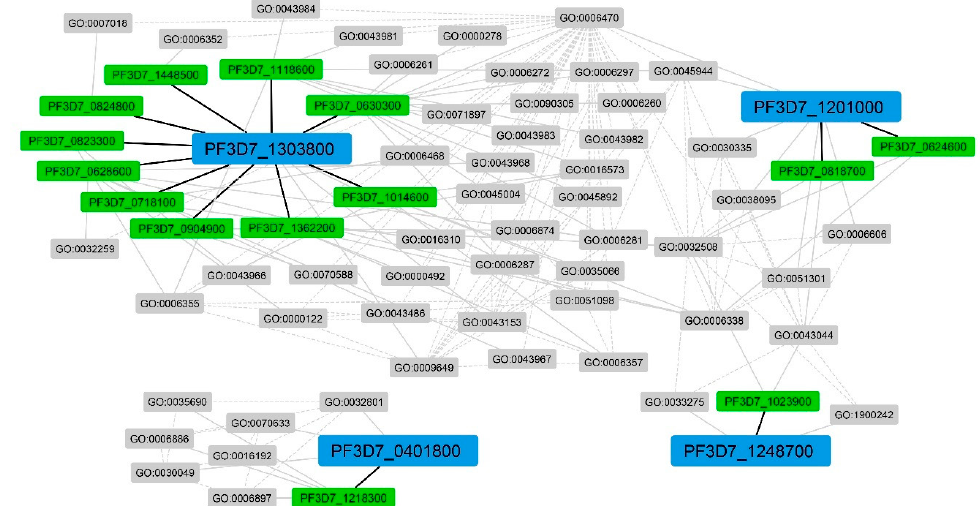
Figure 6. The network shows the connections among PF3D7_1303800 , PF3D7_1201000 , PF3D7_1248700 , and PF3D7_0401800 , their neighboring genes, and their corresponding GO terms. Notice that PF3D7_1303800 has ten neighboring genes while the others have only one or two neighboring genes. Therefore, many GO terms can be found for PF3D7_1303800 . There are some commonly shared GO terms among PF3D7_1303800 , PF3D7_1201000 , and PF3D7_1248700